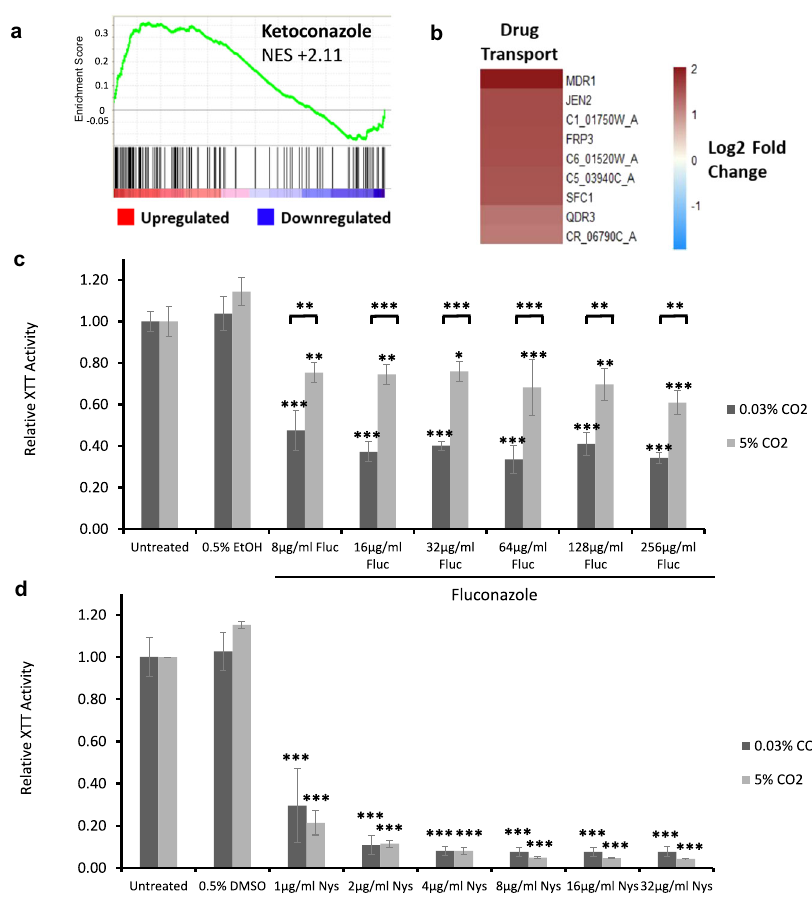
Fig. 8 Antifungal sensitivity of C . albicans bio fi lms grown in high (5%) CO 2 . a GSEA enrichment plot of the KETOCONAZOLE_UP gene set containing genes upregulated in C. albicans cells grown in the presence of Ketoconazole 62 . NES normalised enrichment score; positive NES indicates enrichment in the upregulated group of genes. b Heat map of genes associated with drug transport, including the multidrug ef fl ux pump gene MDR1 . c Bio fi lm growth assay of CAI4pSM2 in the presence of Fluconazole. d Bio fi lm growth assay of CAI4pSM2 in the presence of Nystatin. The relative XTT activity is presented with the 0.03% CO 2 bio fi lms being normalised to the 0.03% CO 2 untreated control and the 5% CO 2 bio fi lms being normalised to the 5% CO 2 untreated control. Two-way ANOVAs followed by Tukey tests for multiple comparisons were carried out: * p < 0.05, ** p < 0.01, *** p < 0.001. Asterisks directly above the bars indicate a signi fi cant difference to untreated in the same CO 2